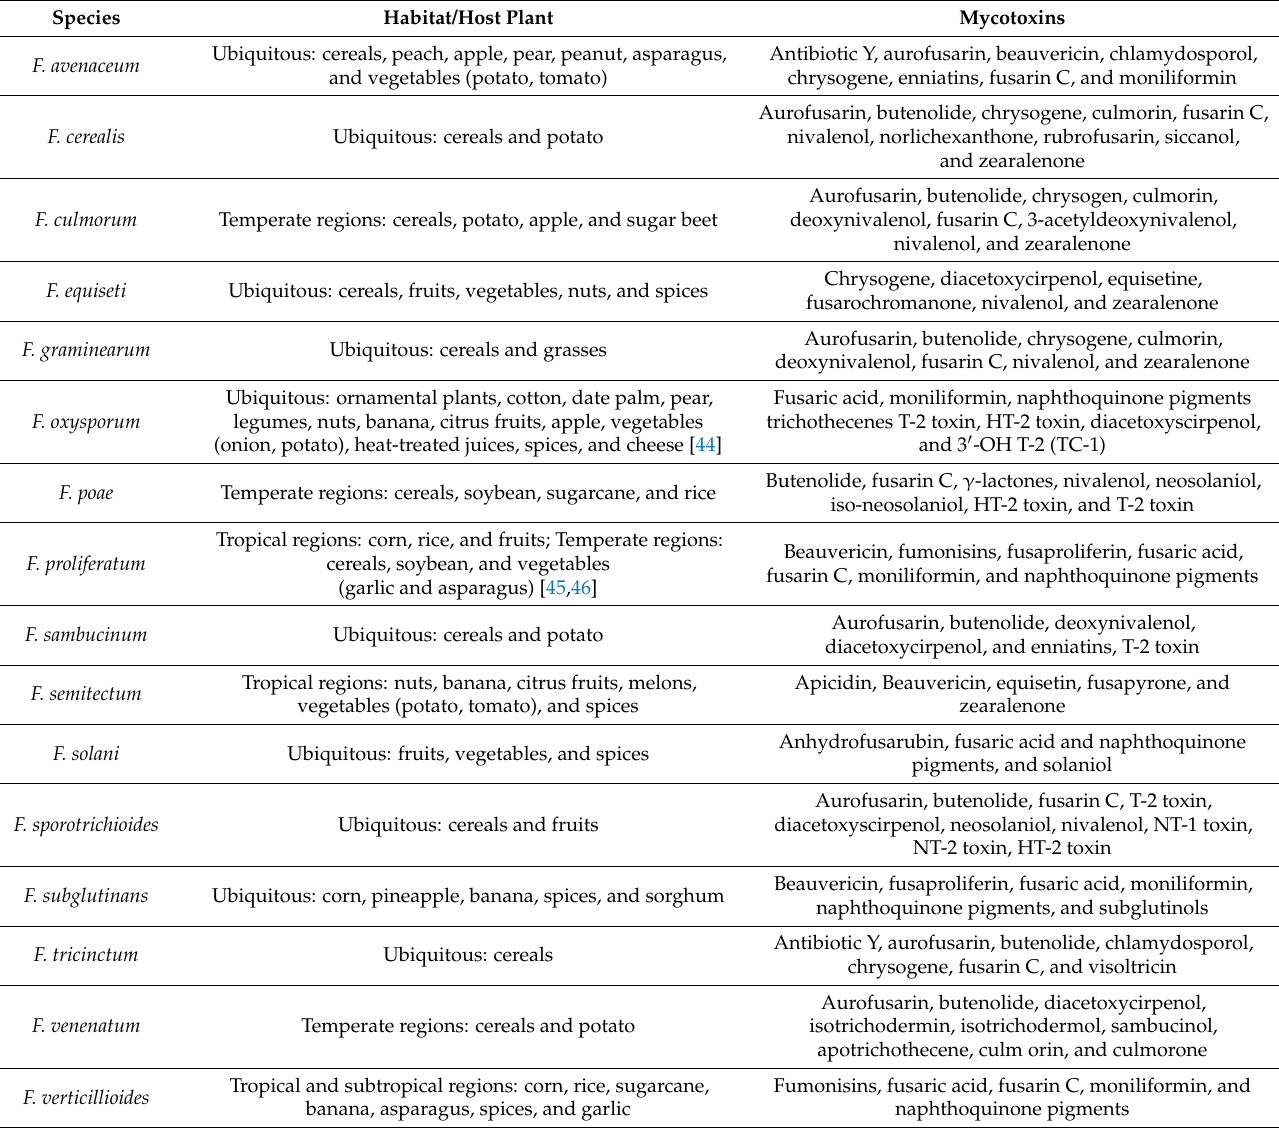
Table 1. Major phytopathogenic Fusarium species and their associated mycotoxins (based on Munkvold et al., 2021; Edel-Hermann and Lecomte 2019; G á lvez and Palmero, 2022; Seefelder et al.,